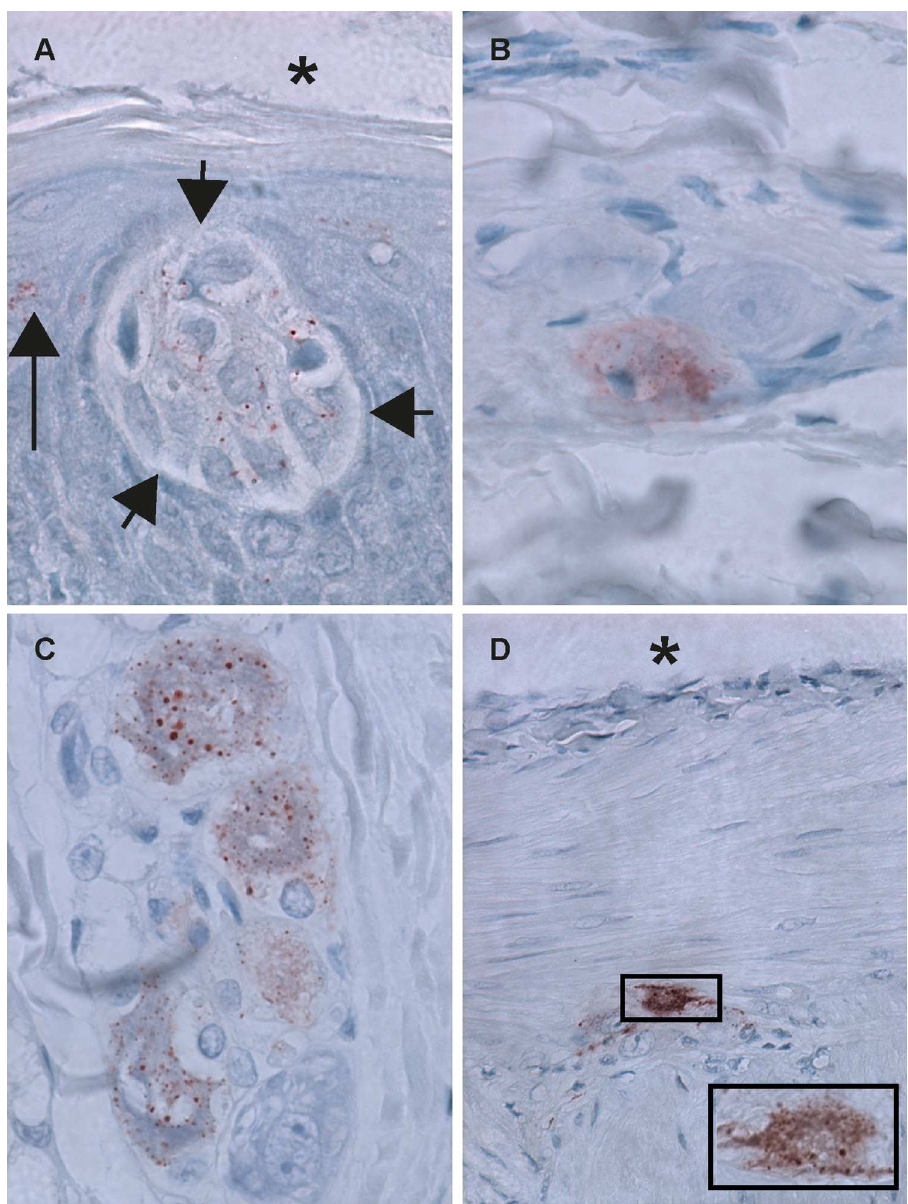
Fig 3. Lyssavirus antigen expression in neurons infected with different strains of Lagos bat virus. All sections immunostained for lyssavirus antigen. Original magnification: x 100 ( A , B and C ); x40 ( D ); x100 (inset of D ) A : Taste bud (between short arrows) bordering the lumen of the oral cavity (indicated with asterisk) in cross section of tongue. Several neuroepithelial cells within the taste bud have small cytoplasmic antigen (red) granules. Epithelial cells directly adjacent to taste buds also occasionally have antigen granules (indicated with long arrow) (Bat 6). B : Three neurons in a ganglion within the connective tissue of a salivary gland. One neuron has small cytoplasmic antigen (red) granules (Bat 12). C : Neurons in a ganglion within the connective tissue of the epicardium (heart). One neuron has abundant small cytoplasmic antigen (red) granules. Directly adjacent one neuron with less antigen granules (Bat 6). D : Neurons within the myenteric plexus (intestine) have abundant small cytoplasmic antigen (red) granules. Asterisk indicates the serosa side of the intestinal wall (bat 11). Inset contains a higher magnification of the image in the square of D .